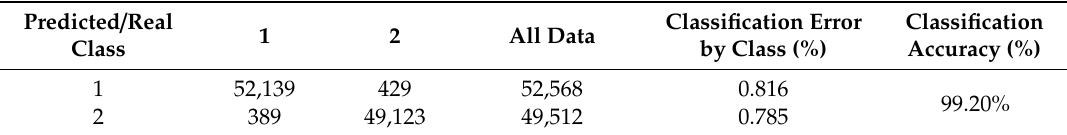
Table 5. Confusion matrix of thresholding function. Classes correspond to: 1: Apple object pixels, 2: Background object pixels.